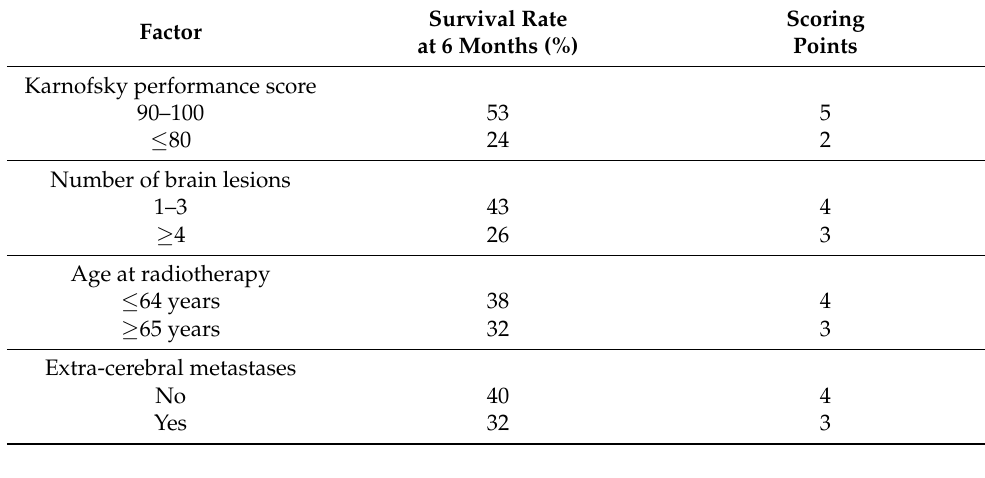
Table 3. Six-month survival rates and related scoring points.